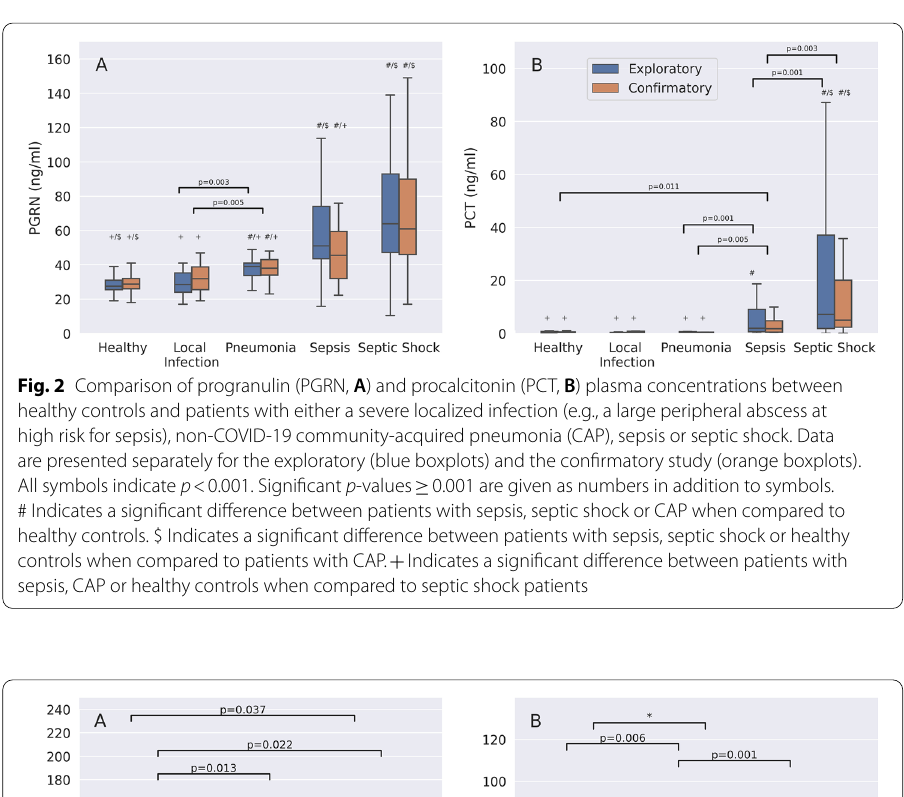
Progranulin concentrations differ according to the primary septic focus When patients were grouped according to the presumed origin of sepsis (pulmonary, abdominal or other locations), those with a pulmonary origin of infection had signifi- cantly higher progranulin concentrations than patients with abdominal infection (only in the confirmatory study, p 0.013) or other causes of sepsis ( p 0.037 exploratory and = = p 0.022 in the confirmatory group) (Fig. 3A). In contrast to progranulin, procalcitonin = values were significantly lower in pulmonary or other causes of sepsis than in abdominal infections (Fig. 3B).